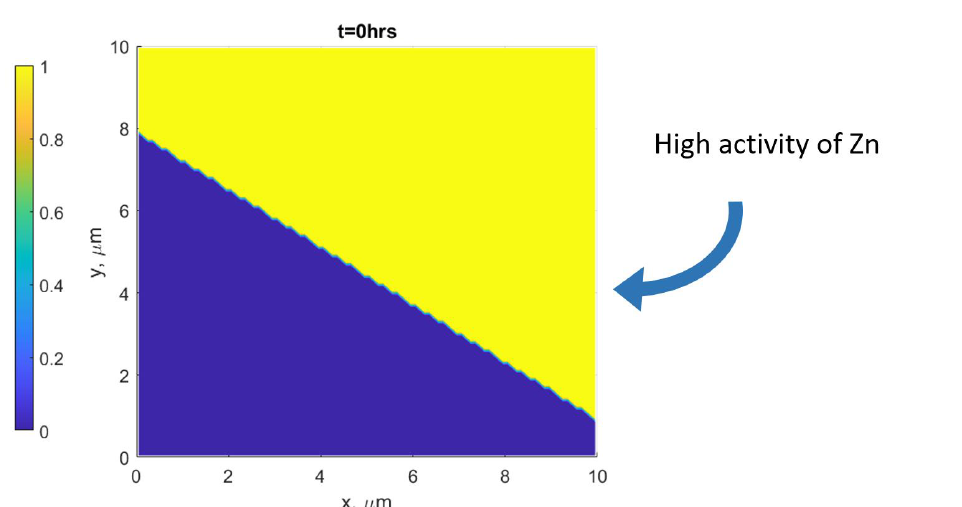
Figure 1. Plot of φ showing the initial setup with a slant grain boundary meeting the surface of high Zn activity.